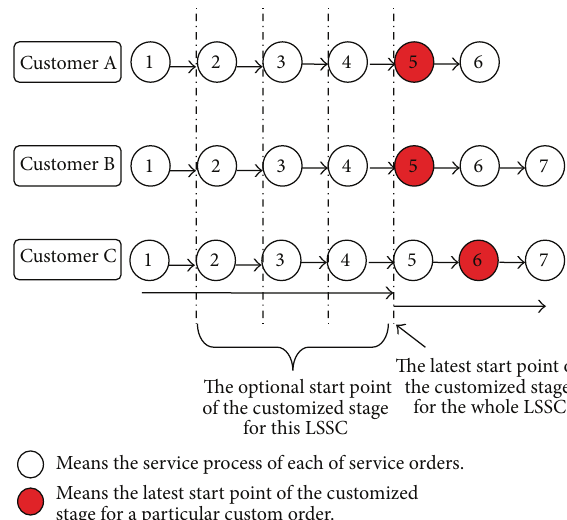
Figure 4: Schematic diagram of each order’s operation process requirement in numerical